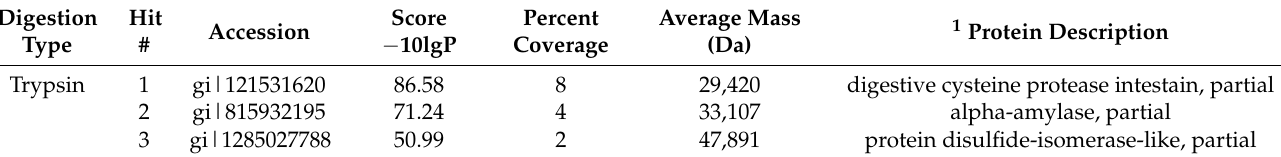
Table 3. PEAKS identification searches of protein spot 51 from CPB midgut, pH 4–7, 18 cm